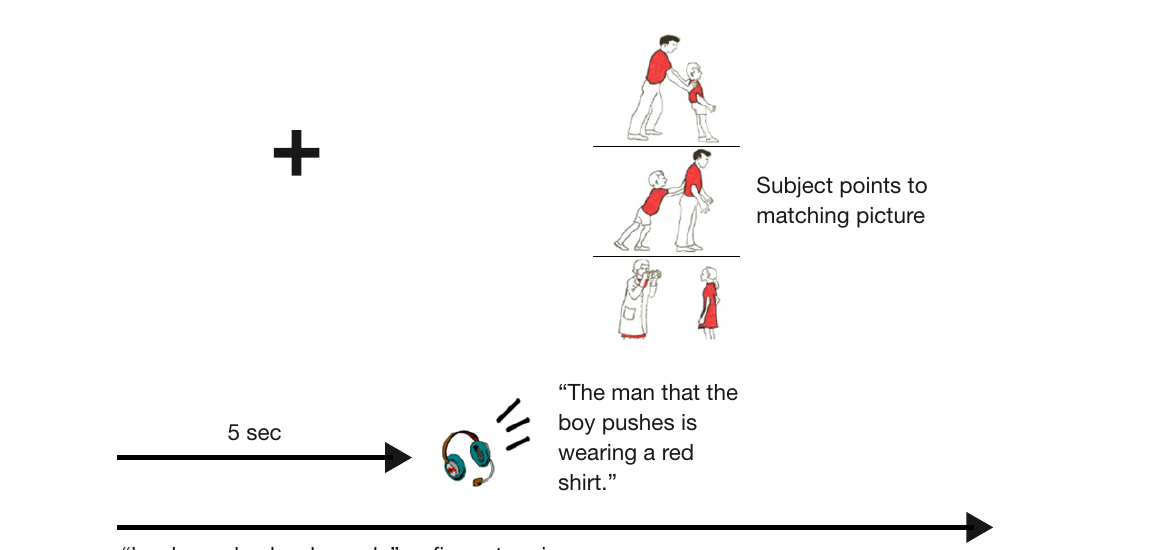
Figure 1 | Schematic of behavioral task paradigm with SOAP stimuli (Love and Oster, 2002). Note that the concurrent task condition was employed during both the initial perception and processing of the sentence, as well as during the post-processing matching